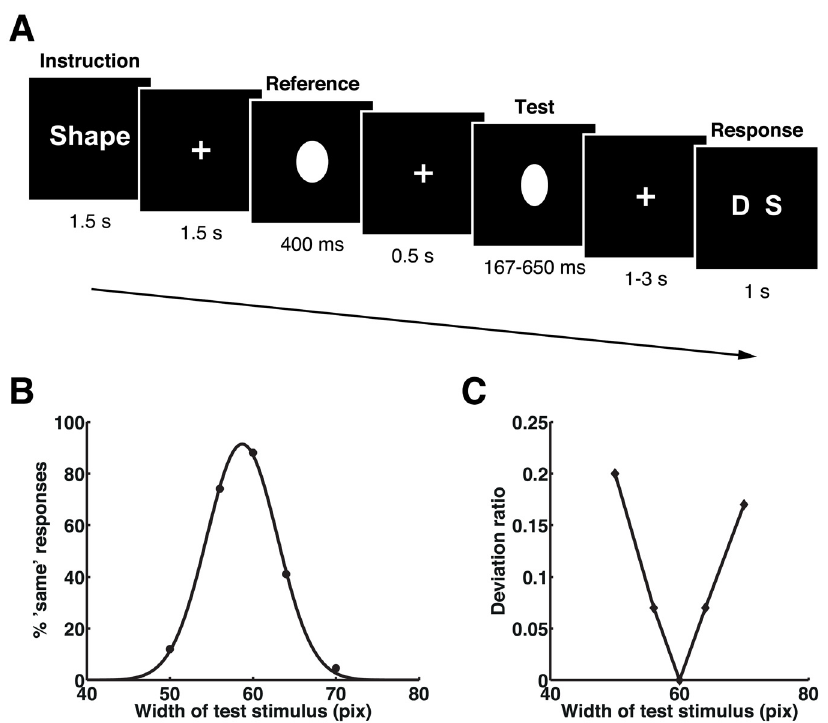
Fig 4. Stimulus sequence, mean task performances, and deviation ratios in experiment 3. (A) The stimulus sequence. Participants were asked to respond with whether the widths of two sequentially presented visual stimuli (ovals) were the same or different. (B) Mean task performances. The proportion of “ same ” responses was fitted by a Gaussian function for presentation purpose. Please refer to S1 Data for the numerical values underlying this figure. (C) Plots of deviation ratios for each set of visual stimulus